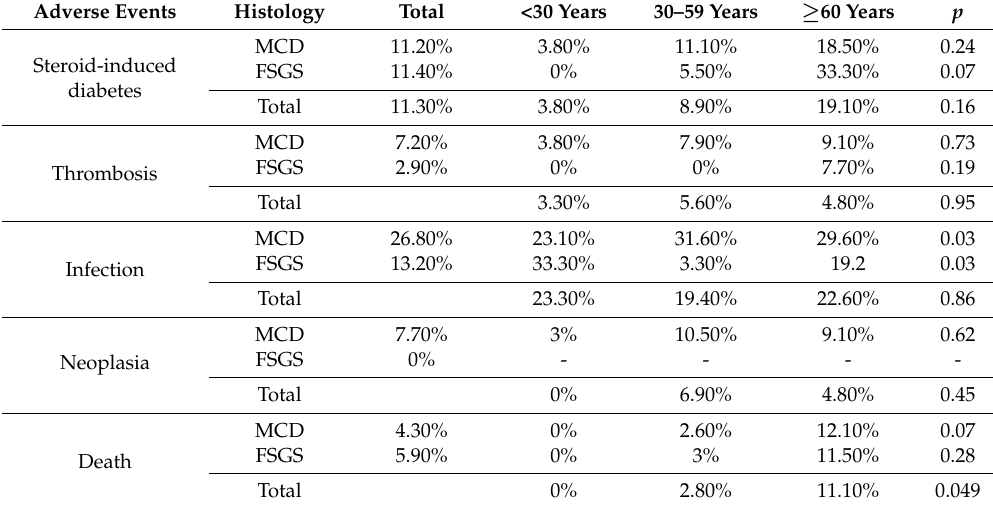
Table 5. Complications occurring in idiopathic MCD and